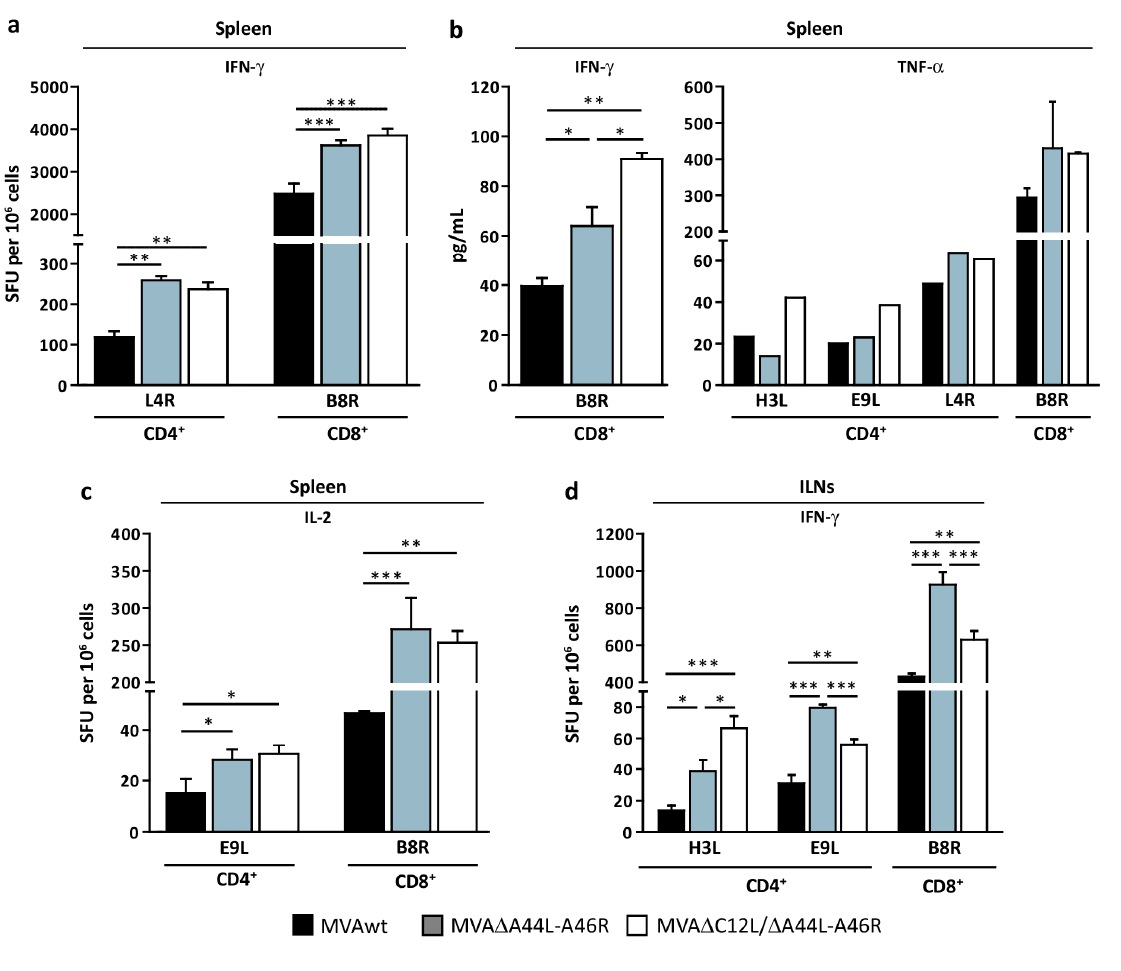
Figure 3. Modulation of specific T-cell response after VACV gene deletion. Groups of four C57Bl/6 mice were i.m immunized and 7 dpi specific T-cell responses were evaluated in spleen ( a – c ) and ILNs ( d ). Magnitude of the response was measured by IFN- γ ( a , d ) and IL-2 ( c ) ELISPOT assays. Specific cytokine production in splenocyte-culture supernatants was evaluated by ELISA ( b , left panel) or CBA ( b , right panel) after stimulation with indicated VACV-peptides. Data are expressed as mean + SD of triplicate ( a – d ) or duplicate ( b ) determinations, and are representative of three independent experiments. Statistical analysis performed by one-way ANOVA and Bonferroni’s post-test. Significant differences: * p < 0.05, ** p < 0.01, *** p < 0.001. SFU: Spot-forming unit.